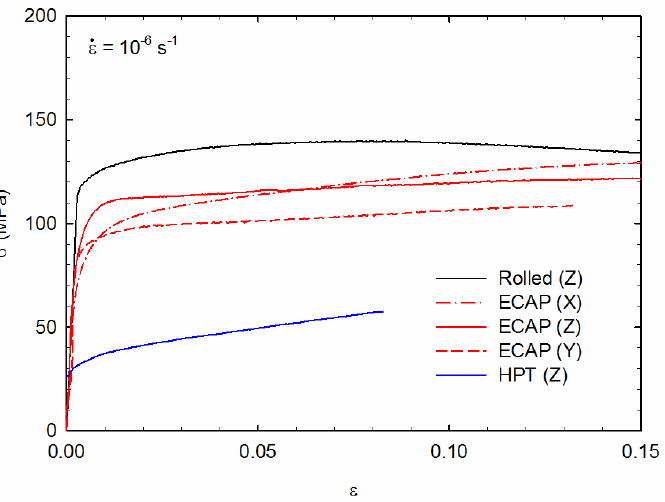
Figure 4. Stress vs. strain curves obtained for pure magnesium processed by rolling, ECAP, and HPT tested at 10 − 6 s − 1 .